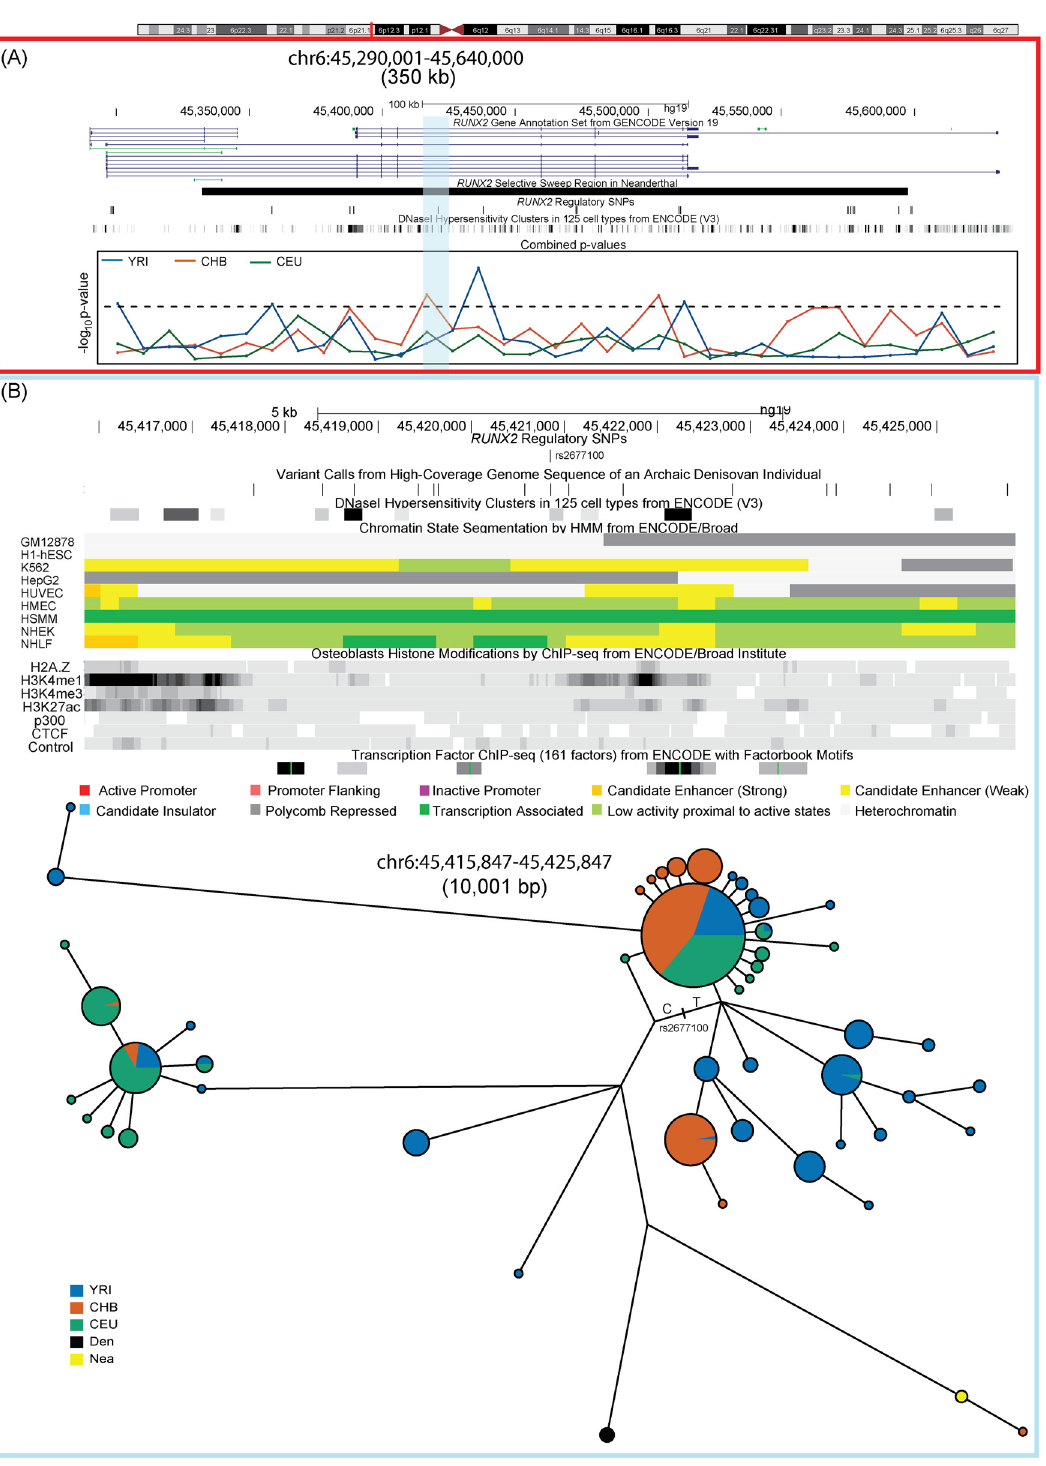
Fig 5. Positive selection at the RUNX2 locus. (A). A 350 kb region on chromosome 6 that spans RUNX2 showing GENCODE (Version 19) transcript annotation and the extent of the selective sweep region identified in the archaic Neanderthal genome. The positions of 22 candidate regulatory variants and DNase I Hypersensitivity Clusters are shown along with the − log 10 of the combined p-values from frequency-spectrum-based analysis in three continental populations. The significance threshold is depicted by the dashed line and two non-overlapping 10 kb windows have a significant combined p-value in CHB and YRI. (B). A closer look at the first selected region in East Asians (highlighted in blue). The region contains the variant with the highest derived allele